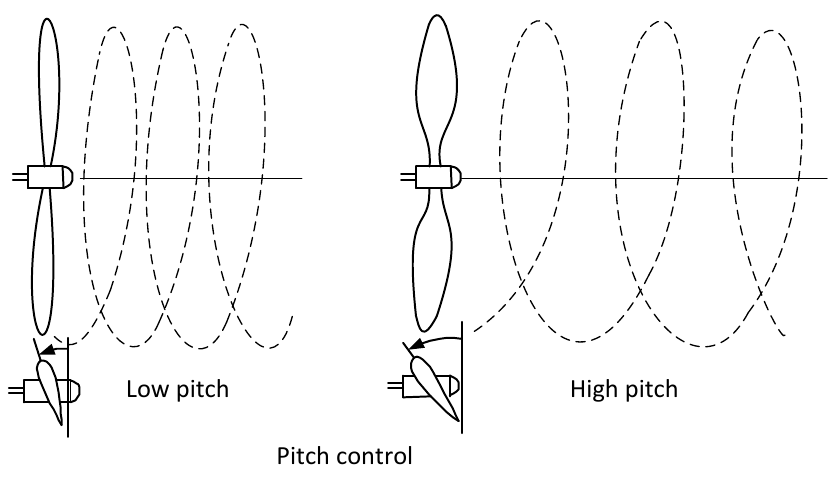
Figure 1. Definition of propeller pitch.